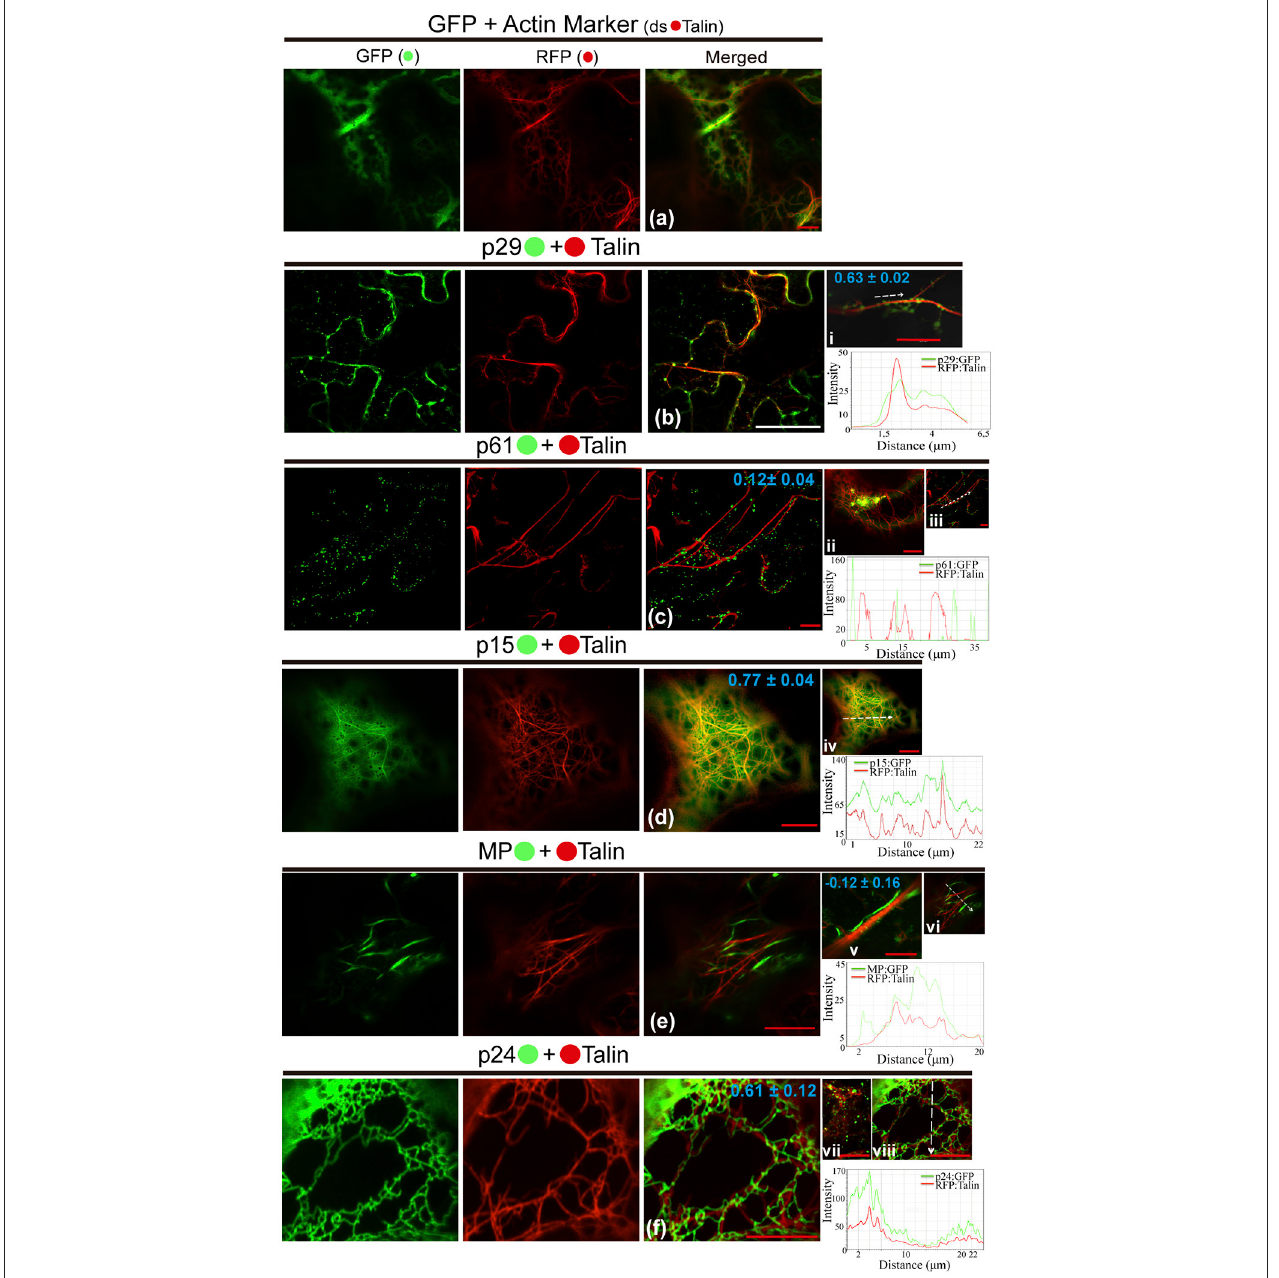
FIGURE 5 | The p29, p15, and p24 CiLV-C proteins co-localize with actin microfilaments. The p29, p15, p61, MP, and p24 proteins fused at their C-termini with eGFP (•) were co-expressed with dsRFP-(•) Talin (actin marker) in epidermal cells of N. benthamiana . Fluorescent signals were captured 72h post-infiltration (except for p61, captured 24–36 hpi) with confocal microscope Leica SP8 model. The green (GFP), red (RFP) channels and merged images are shown in the figure. (a) Image show unfused GFP expression in a diffuse signal evenly distributed in the cytoplasm with tagging of actin skeleton from expression of the actin marker. (b) Epidermal cells show p29:eGFP punctuate bodies associated with actin filaments. Image in (i) shows only one actin filament with several p29:eGFP punctate bodies co-localized along the filament. (c) No co-localization of the p61:eGFP individual bodies or agglomerates (ii) along the actin filaments. (d) p15:eGFP, apparently diffused throughout the ER, co-localizes emerging on actin network. (e) Image shows MP:eGFP filaments expression that do not co-localize with actin marker. This observation is more conclusive in image (v), where direct association between the MP:eGFP filaments along the actin filament is not visualized in a higher magnification. (f) Epidermal cells showing actin filaments wrapped around by p24:eGFP filament-like structures. (vii) Image of the p24:eGFP in spherical structures (possible vesicles) is observed throughout the actin filaments. The mean SD of PCC at the top of the merged image and chart of fluorescence intensities further confirm the co-localization of the p29, p15, and p24 with actin (merged pictures i, iv, viii, respectively). Plot shows green and red fluorescence intensities, indicated by (CiLV-C-Proteins):GFP and RFP:Talin in the selected region of interest (dotted arrows). Distance measurement starts from the base to the tip of the arrows (x axis). Red and white bars correspond to 10 and 50 µ m,